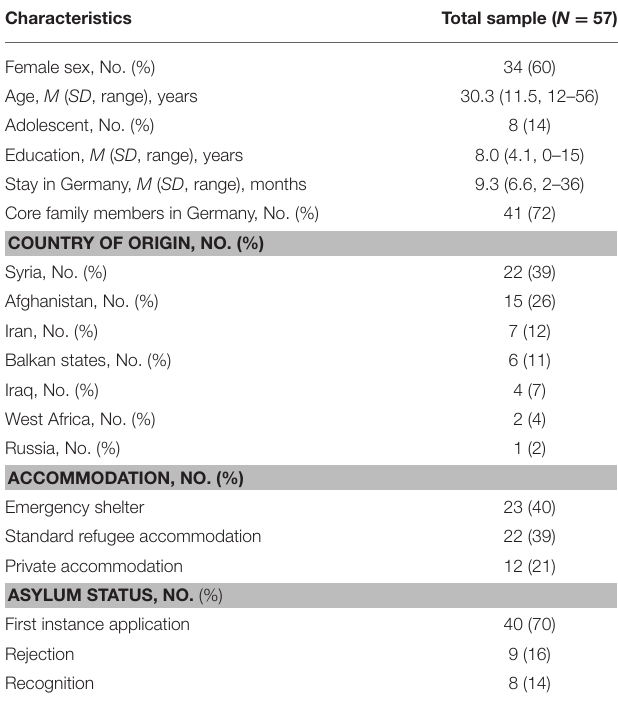
TABLE 1 | Socio-demographic characteristics.